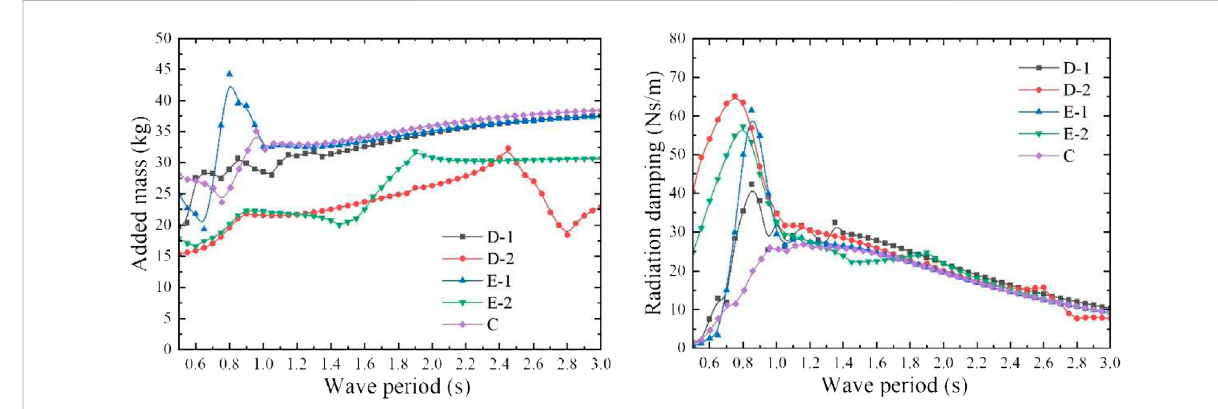
FIGURE 15 Heave added mass and radiation damping coef fi cient of the models with different bottom shapes.